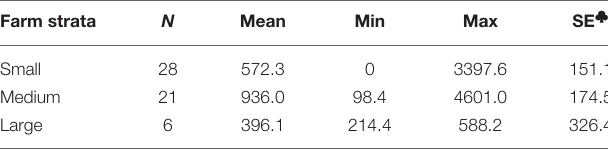
TABLE 4 | Descriptive statistics of yearly financial losses associated with SCM adjusted to 10 cows per farm per year stratum (US$).